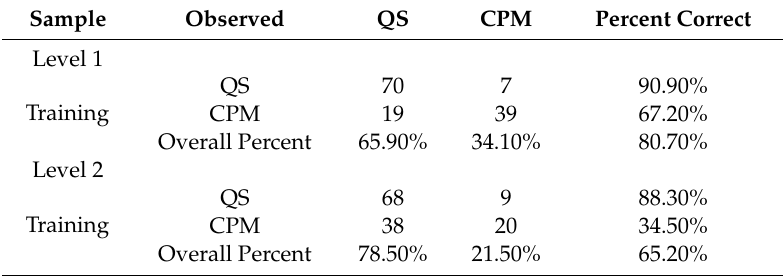
Table 5. Classification of predicted observed outcome from the multilayer perceptron.